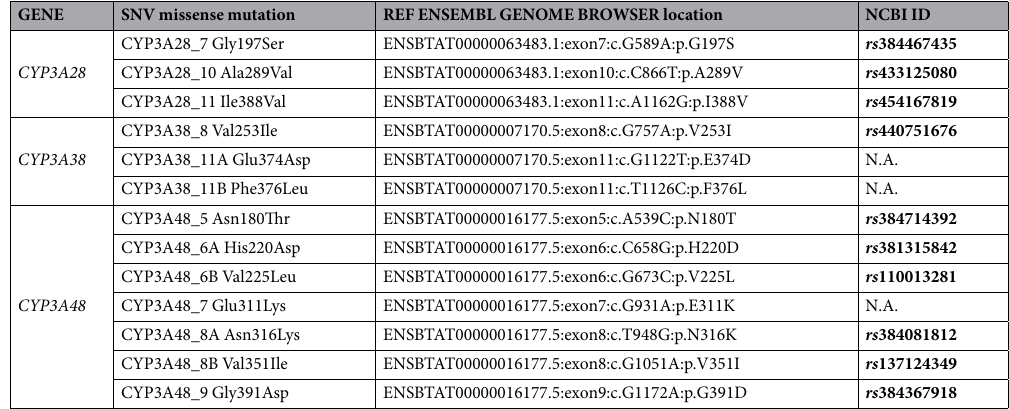
Table 1. Missense variants identified in b CYP3As . N.A. = not available.